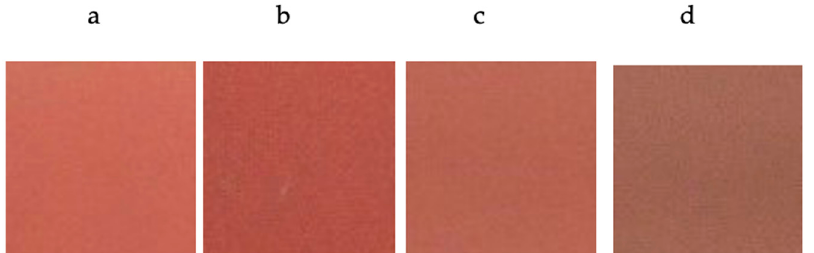
Figure 7. Color development of glazed tiles with fired pigment 1500 ◦ C/6 h with 5% w / w CaF 2 addition. ( a ) Y 0.99 AlCr 0.01 O 3 ; ( b ) Y 0.97 AlCr 0.03 O 3 ; ( c ) Y 0.95 AlCr 0.05 O 3 ; ( d ) Y 0.90 AlCr 0.10 O 3 .